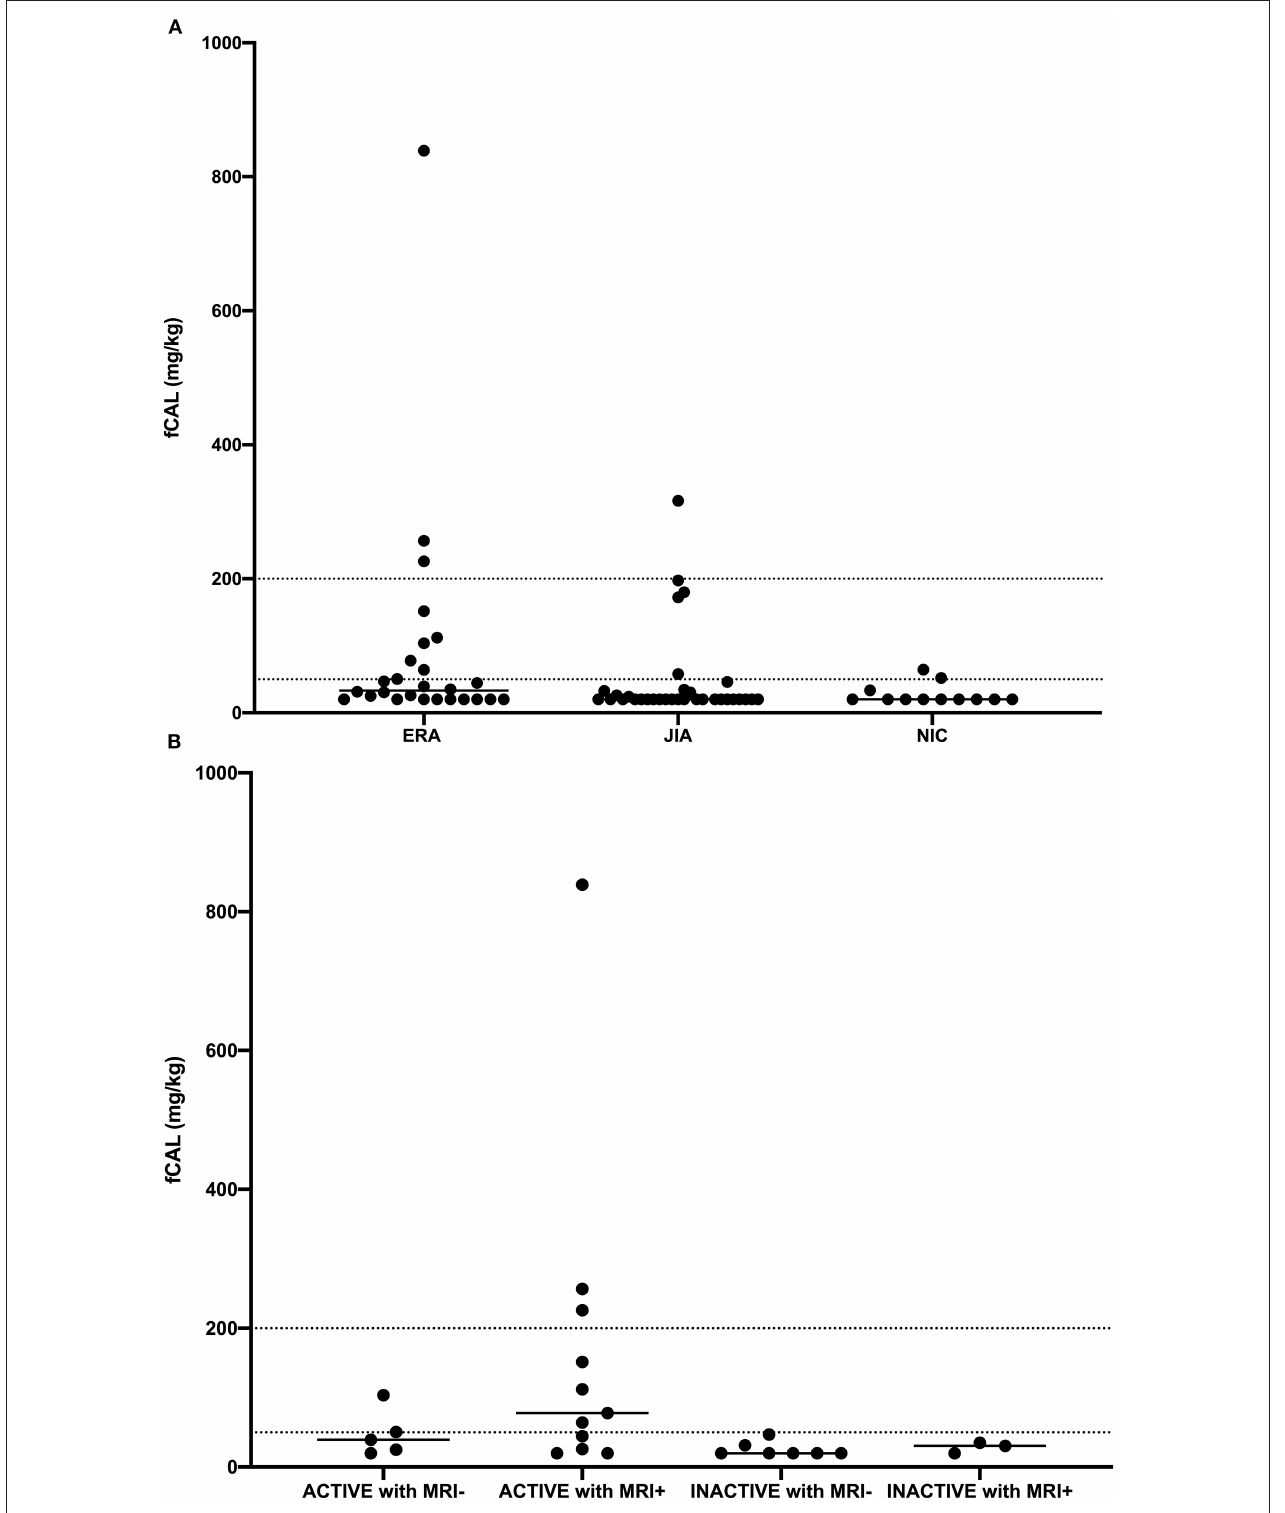
FIGURE 1 | Fecal calprotectin (fCAL) concentration in (A) enthesitis related arthritis (ERA), oligo- and polyarticular juvenile idiopathic arthritis (JIA), and non-inflammatory control (NIC) patients, and (B) enthesitis related arthritis (ERA) patients with active and inactive disease, with (MRI + ) or without (MRI-) inflammatory changes detected by MRI. Each dot represents fCAL concentration in a single patient, while horizontal lines represent median values.